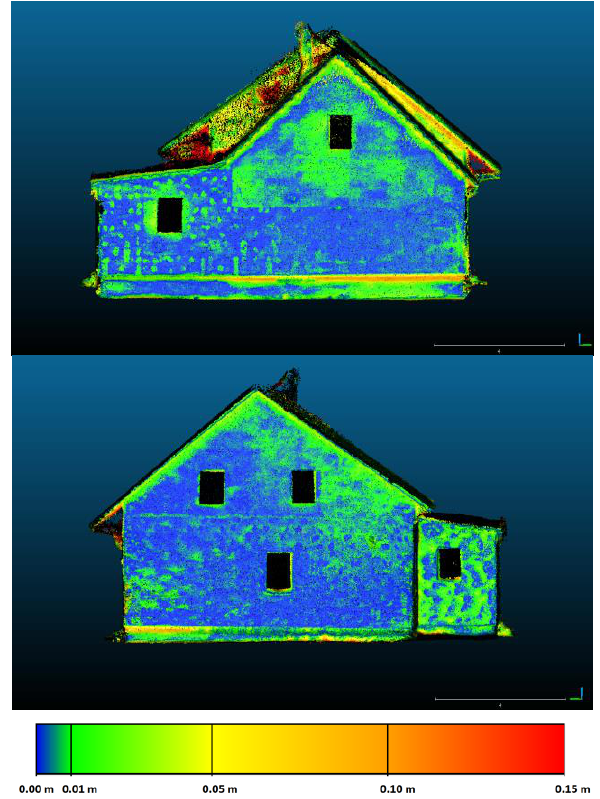
Figure 8. Comparison of point cloud from RGB images captured by thermal camera FLIR E95 and Leica BLK360 laser scan.